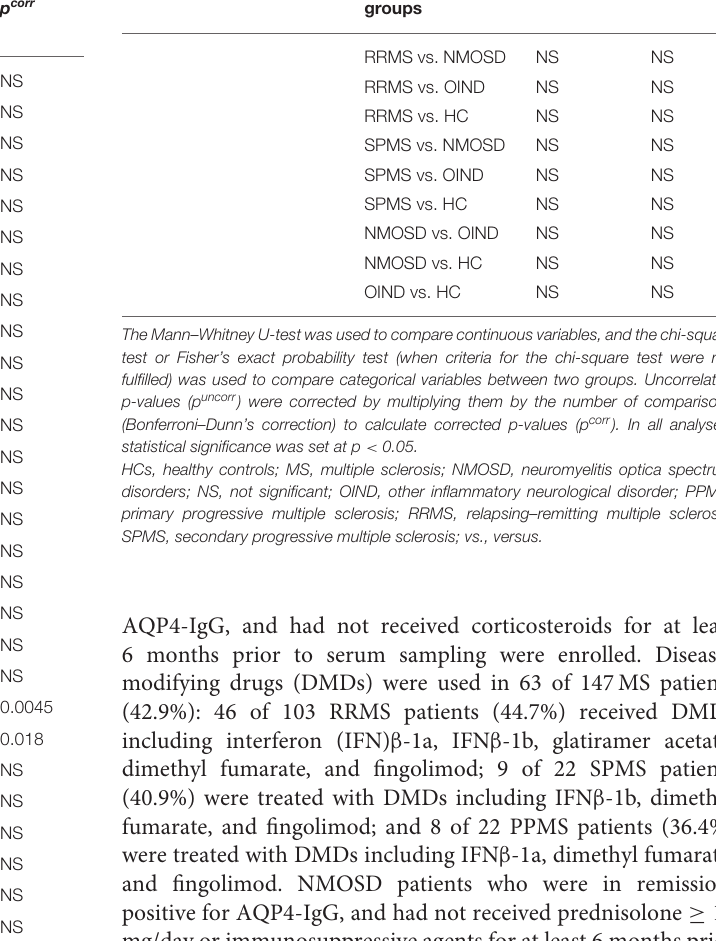
TABLE 2 | Comparison of demographic data and anti-oligodendrocyte antibody status of the study participants. Comparison